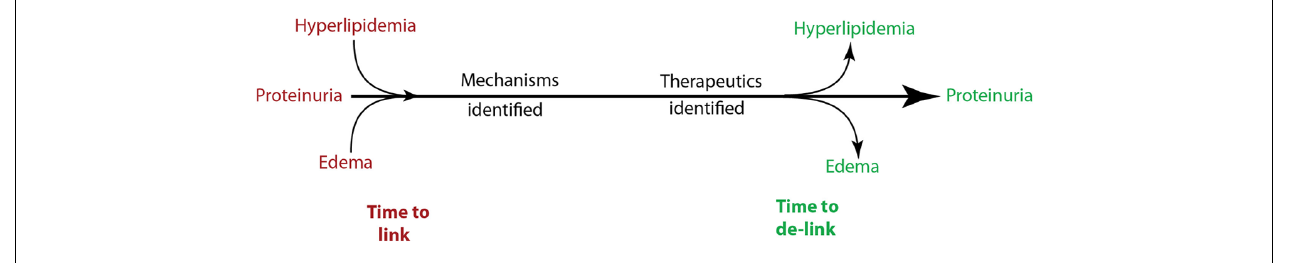
FIGURE 1 | Overall strategy for development of novel therapeutic modalities to treat proteinuria and chronic kidney disease.